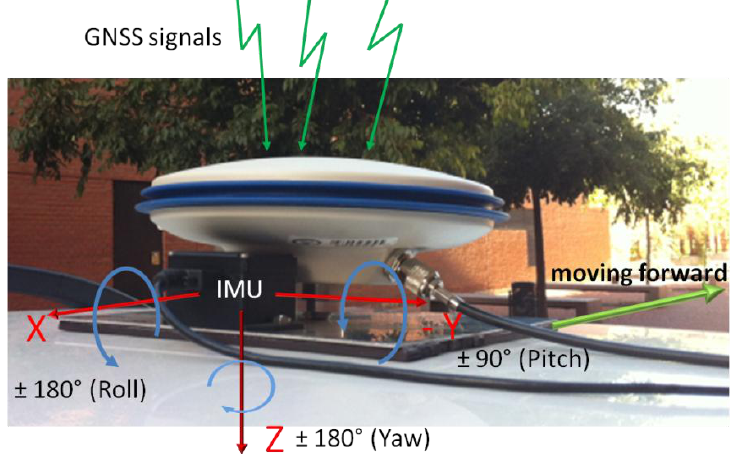
Figure 1. Integration of GNSS antenna of rover receiver and IMU in a platform over the roof of the